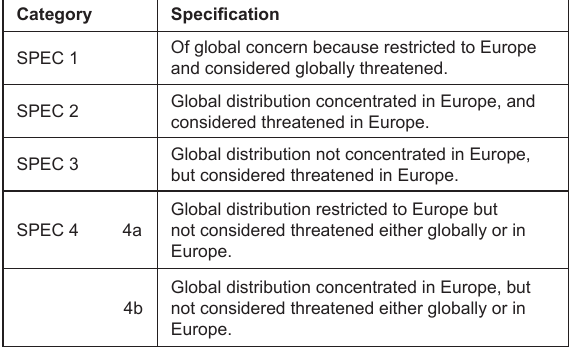
Table 1. Concept of ‘Species of European Conservation Concern’ (SPECs) in designating conservation importance, based on (1) global conservation status, (2) European threat status and (3) proportion of world range in Europe (From Van Swaay et al. 2009) (‘Threatened’ is one of Critically Endangered, Endangered or Vulnerable)